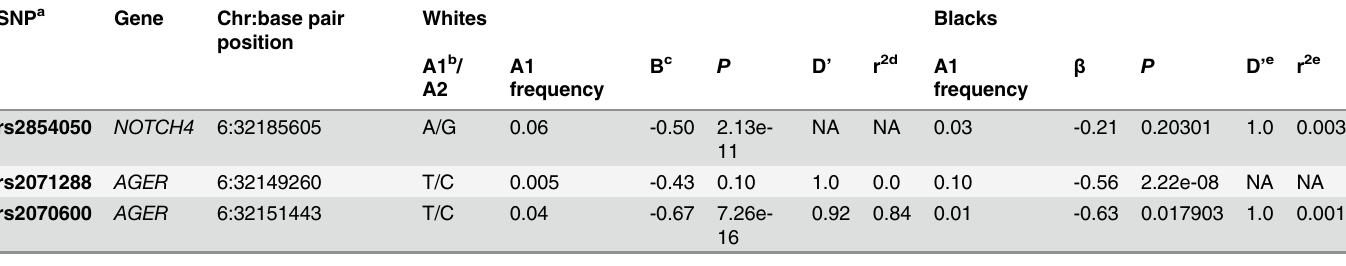
Table 2. Genome-wide significant loci and corresponding trans-ethnic results for sRAGE levels in whites and blacks. SNP a Gene Chr:base pair